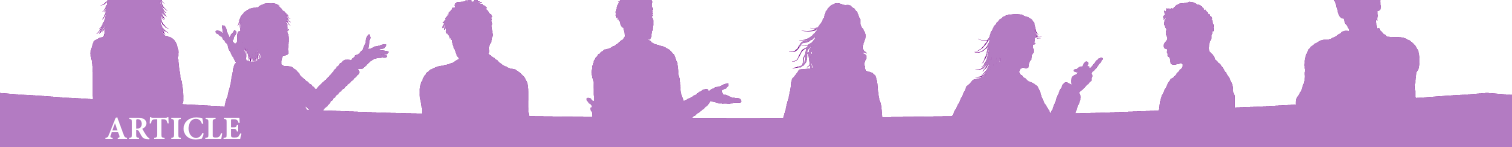
Table 3. ROC analysis for tests for dementia v. non-dementia